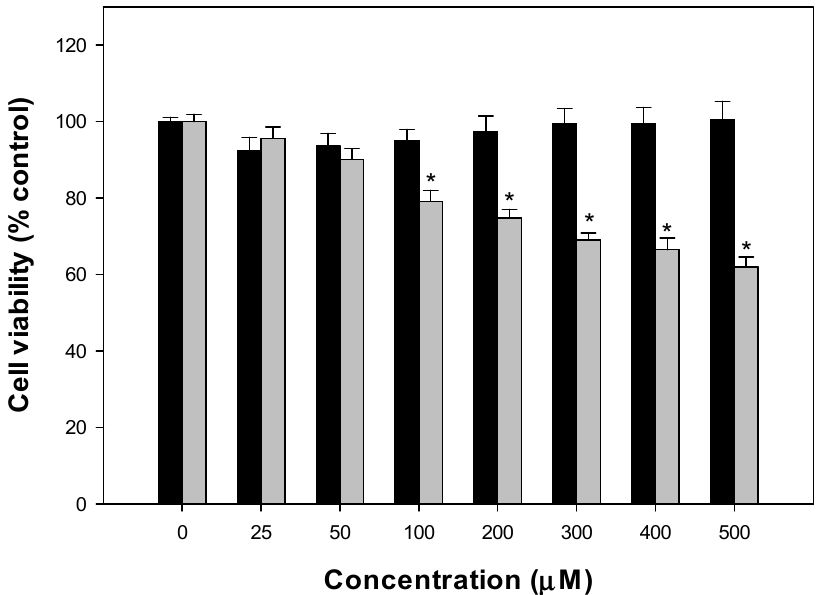
Figure 4. Effects of naringin (black) and VONarg (grey) on A549 cell line viability. Cells were incubated in serum-free Dulbecco’s modified Eagle’s medium (DMEM) alone (control) or with different concentrations of the compounds at 37 °C for 24 h. The results are expressed as the percentage of the control level and represent the mean ± SEM. * Significant difference with control at the 0.05 level.